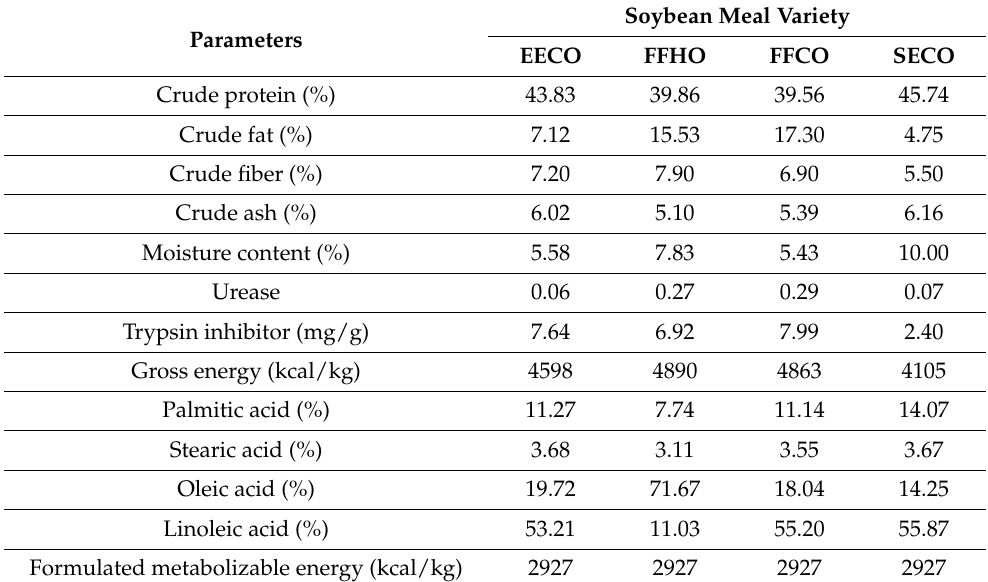
Table 2. Comparative Chemical Composition of Various Processed Soybean Meals *.